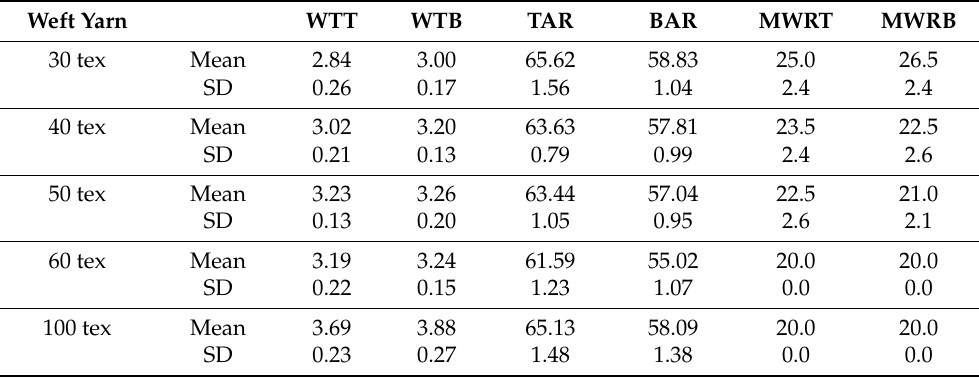
Table 2. The results from the MMT.